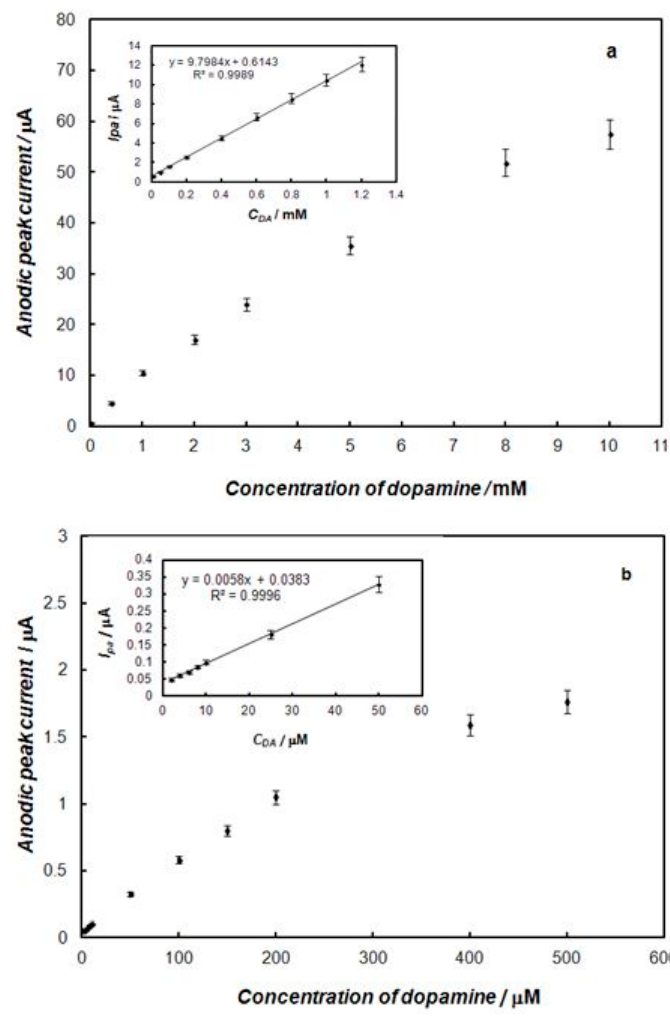
Figure 8. Effect of concentration of dopamine on the oxidation peak current using: ( a ) cyclic voltammetry, and ( b ) square-wave voltammetry, recorded at the gold electrode modified with the polypyrrole—MCM-48 nanocomposite. The inset in figures show a linear relationship for dopamine concentration.